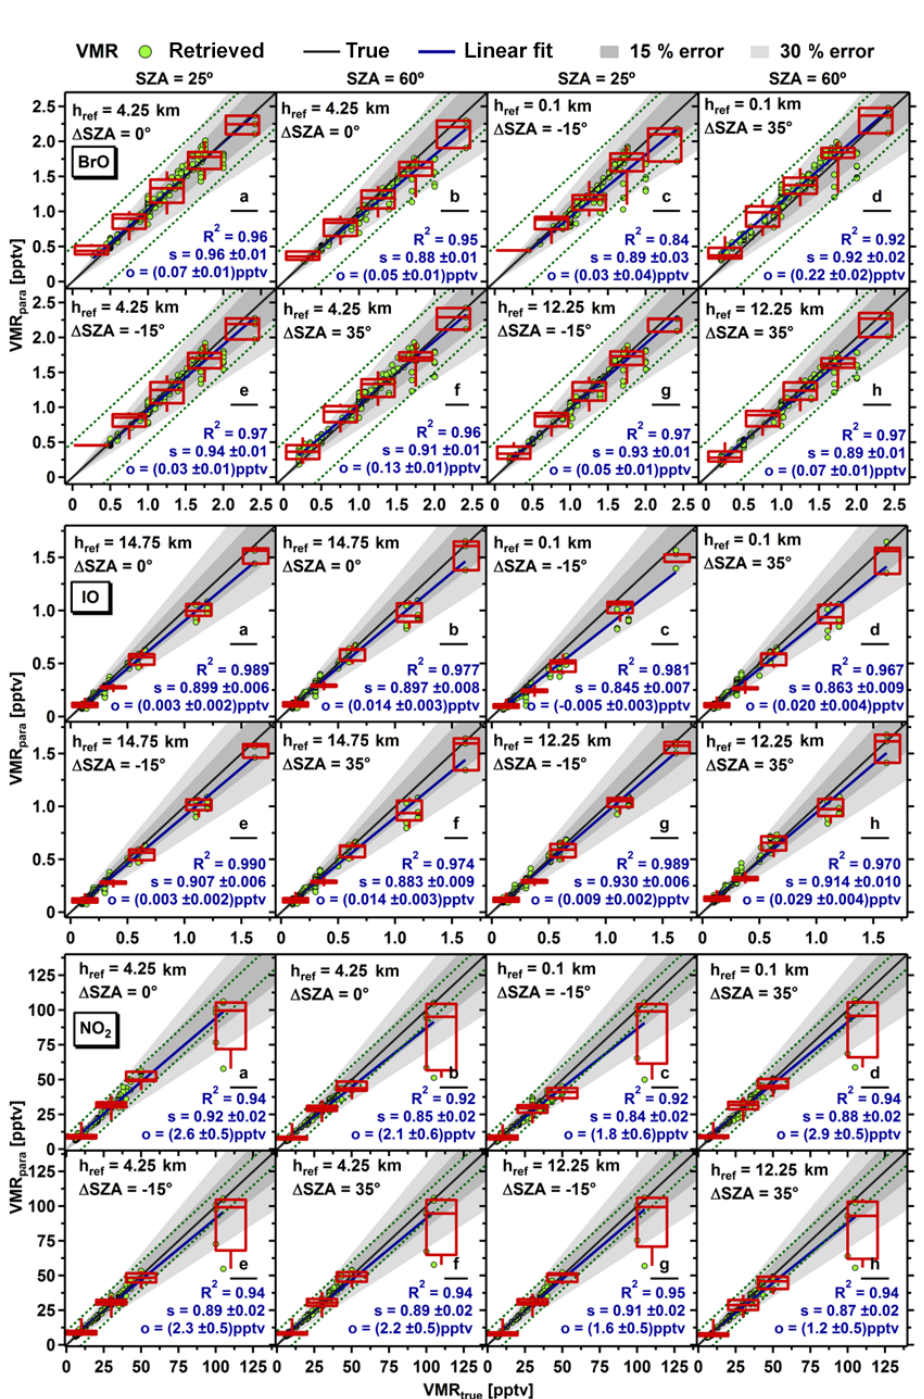
Figure 5. VMR para over VMR true for BrO (top), IO (middle) and NO 2 (bottom) averaged over all BrO and IO trace gas profiles, over NO 2 b and c profiles and over all aerosol profiles for select SZA, (cid:49) SZA and h ref . The panel columns alternate between low (SZA = 25 ◦ ) and high SZA (SZA = 60 ◦ ). The whisker plots show the median and 5, 25, 75 and 95 percentiles for binned VMR para data. Grey shaded areas indicate 15 and 30% error. Linear fits and fit parameter (s: slope; o: offset) are included in each